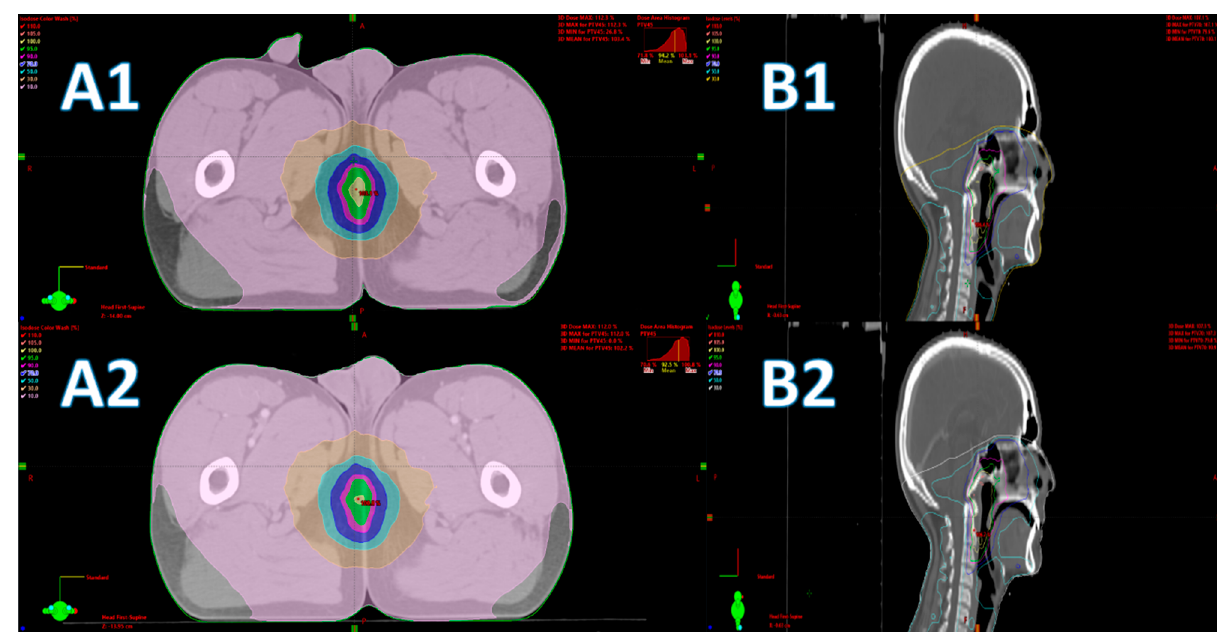
Figure 7. Reduced gamma pass rates in some patients’ plans are the result of patients geometrical differences between NCCT and CCT scans. Subset A shows the difference in geometry due to penile movement, ( A1 ) NCCT, and ( A2 ) CCT. Subset B shows respiratory induced oral cavity movement between NCCT ( B1 ) and CCT ( B2 ).